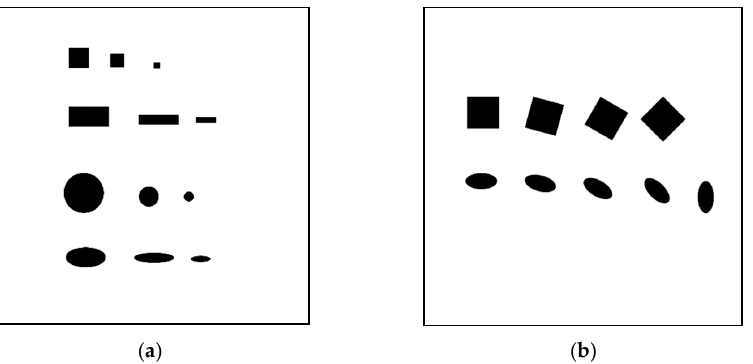
Figure 4. Two examples of test images used for the assessment of the image processing paradigm: ( a ) reference picture and ( b ) rotated picture.